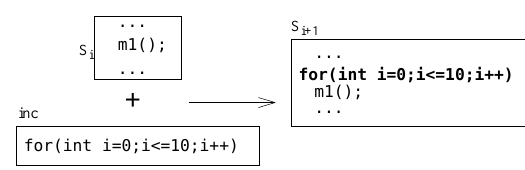
Figure 11. Increment by adding repetition construct.